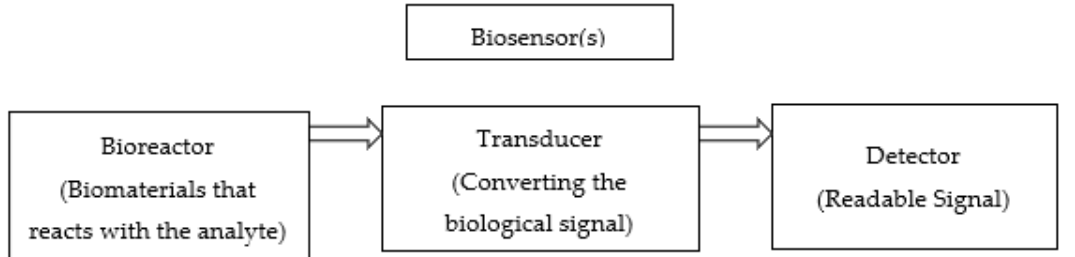
Figure 1. Block diagram of biosensors in order.